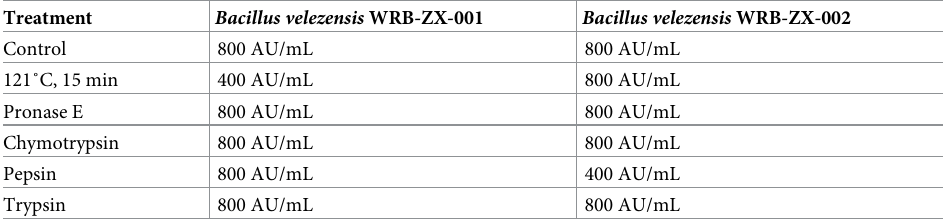
Table 4. Antifungal activity of heat-treated and protease-treated purified products of Bacillus velezensis isolates against food-isolated Aspergillus fumigatus